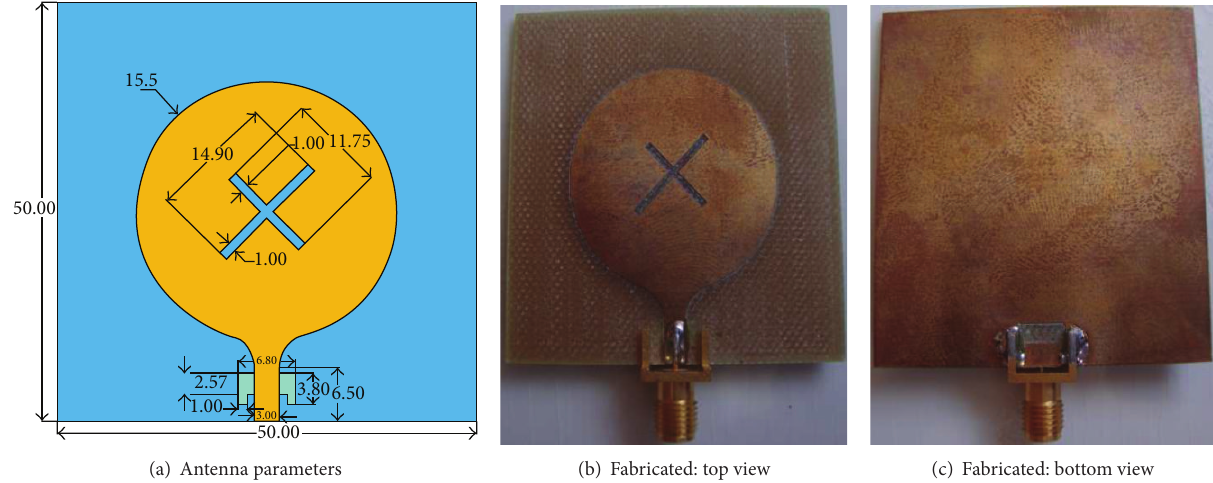
Figure 6: Multiband antenna, (a) antenna parameters, and fabricated antenna: (b) top view and (c) bottom view.